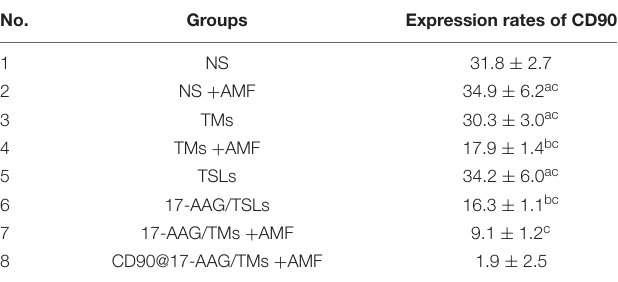
FIGURE 4 | Targeted therapy of CD90@17-AAG/TMs in different groups. (A) H&E staining of the tumor tissues in different groups ( × 20, black arrows represent Fe 3 O 4 nanoparticles, red arrows represent tumor tissues, and blue arrows represent necrotic tissue). (B) CD90 IHC staining of the tumor tissues in different groups ( × 40, green arrows represent the CD90-positive cells). 1. NS, 2. NS + AMF, 3. TMs, 4. TMs + AMF, 5. TSLs, 6. 17-AAG/TSLs, 7. 17-AAG/TMs + AMF, and 8. CD90@17-AAG/TMs + AMF. TABLE 2 | Tumor volume and tumor mass IRs in the different groups (%). TABLE 3 | CD90 expression rates in tumor tissue of mice